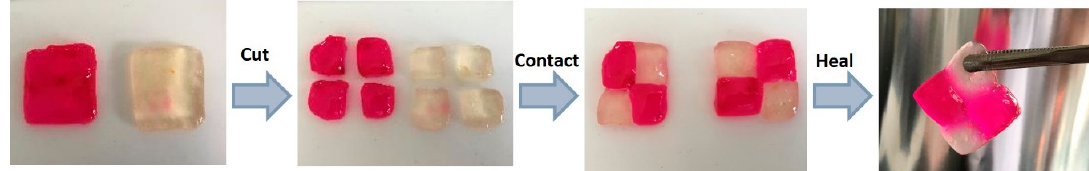
Figure 3. Digital photos of the self-healing process of CMC-OSA-DTP hydrogel pieces (red pieces were stained with rhodamine B for visual discrimination.).